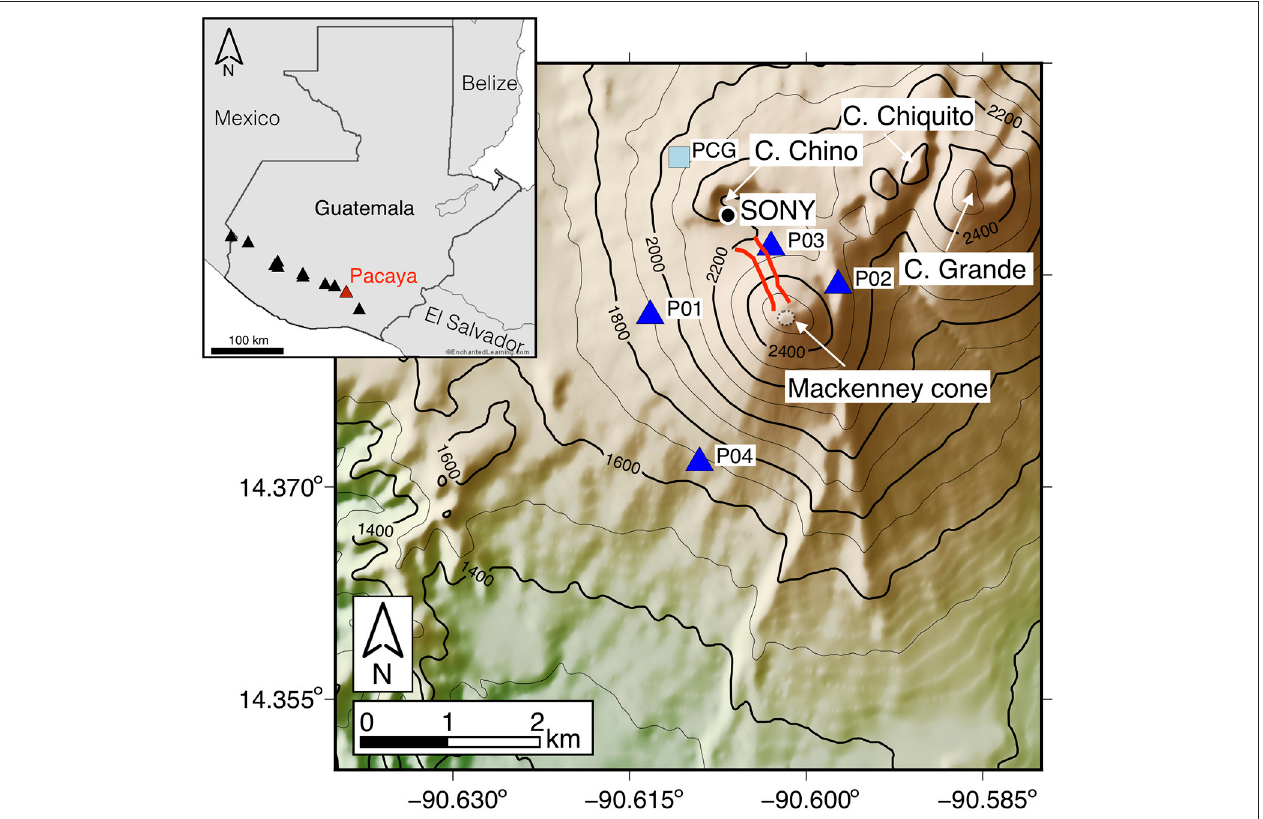
FIGURE 1 | Map of Pacaya volcano showing the location of the seismic stations used in this study (blue triangles). The single permanent station of the local network, PCG, is shown by the light blue square. The black circle indicates the position of the portable SONY video camera used during the field campaign. Red lines indicate the linear depression that developed during the May 27, 2010 eruption. Contour interval is 100m. The box in the upper left corner shows the position of Pacaya volcano in Guatemala with respect to the Central American Volcanic Arc volcanoes marked as black